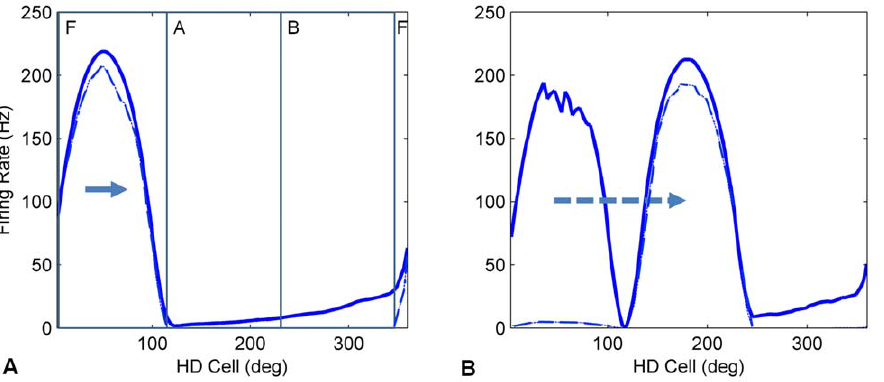
Figure 2. Turn gain is updated when the HD bump is reset by landmark input. (A) The bump is travelling to the right, as indicated by the arrow, at approximately 40 deg/sec. However the head is turning at approximately 65 deg/sec, meaning that the HD turn gain is too low. The dot- dash line shows the instantaneous firing rate; that is, the HD cells which are currently firing, denoted as region F. These cells do not send a gain adjustment signal if they receive landmark input. The solid line shows the firing rate trace; the region of the network immediately behind the bump, denoted as region B, shows higher trace activation than the region just ahead of the bump, region A. HD cells in region B send a gain reduction signal if they receive landmark input while cells in region A send a gain enhancement (discussion of how this signal may be implemented in nervous systems is in section 4). The demarcation between regions A and B is based on the firing rate trace activation threshold of 10 Hz. (B) 120 ms later, the HDAAN has received landmark input causing the bump to jump ahead to the landmark location at 180 u . Since most of the HD cells which received landmark input were in the low activity-trace region (region A), the turn gain is increased overall.